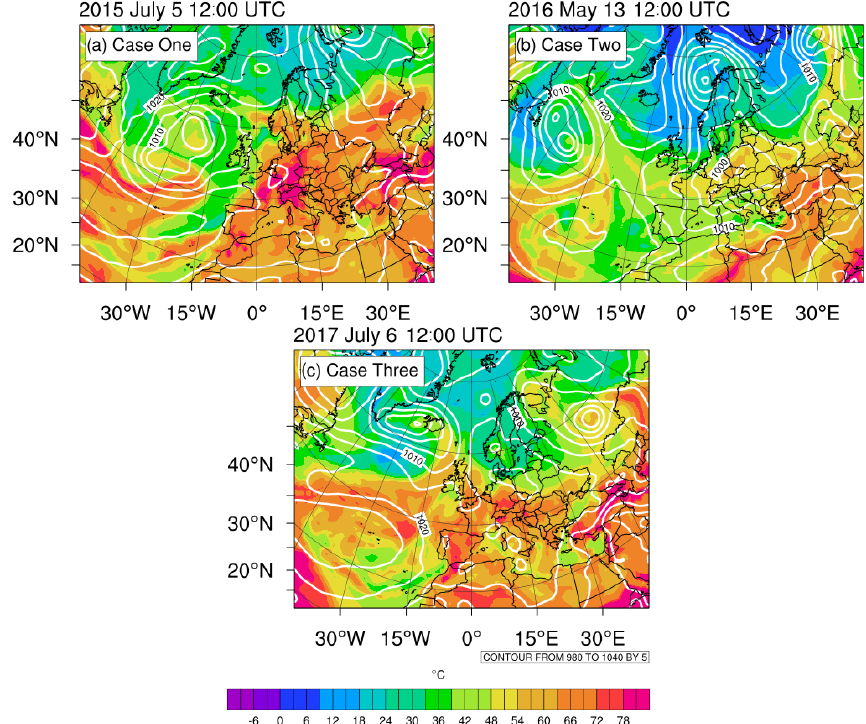
Figure 1. Synoptic conditions for the three different cases – surface pressure reduced to mean sea level and 850hPa pseudo-equivalent potential temperature. The plots are based on GFS analysis data.